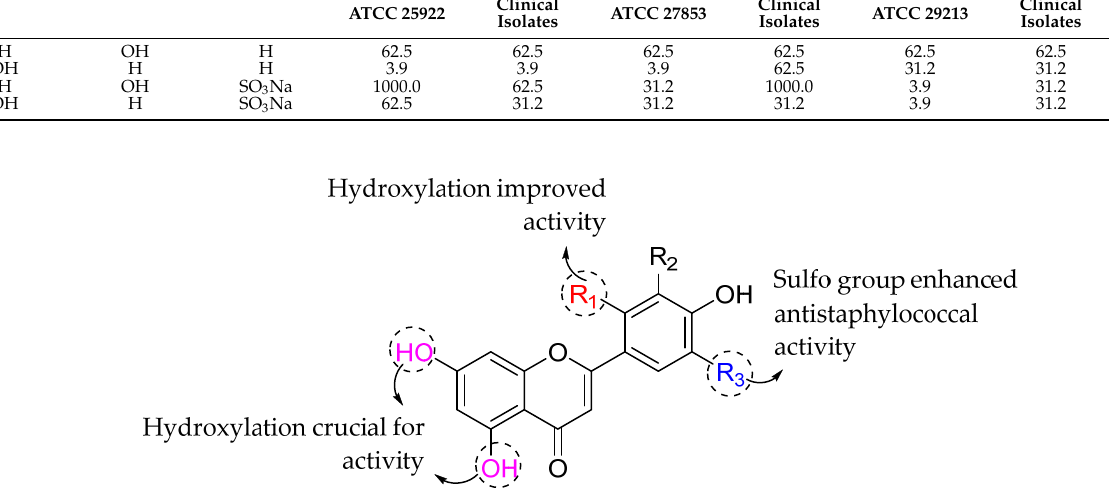
Figure 30. SAR analysis of flavonoids and their sulfonic derivatives as antibacterial agents [100]. Oliveira et al. (2021) investigated the effects of fatty acid chain length differences in Table 21. Antibacterial activities of anthocyanins bearing fatty acid moiety in sugar portion. anthocyanins, particularly cyanidin-3-glucoside, on antibacterial activity. The glucoside with a fatty acid chain was inserted at C3 of cyanidin’s ring A, and the length of the fatty Compounds acid chain ranged from C4 to C12. Their bacterial inhibition can be observed in Table 21. Compared to other compounds with fatty acid chains, cyanidin-3- O -glucoside ( 12a ) with no fatty acid chain was found inactive. Following that, it was discovered that the